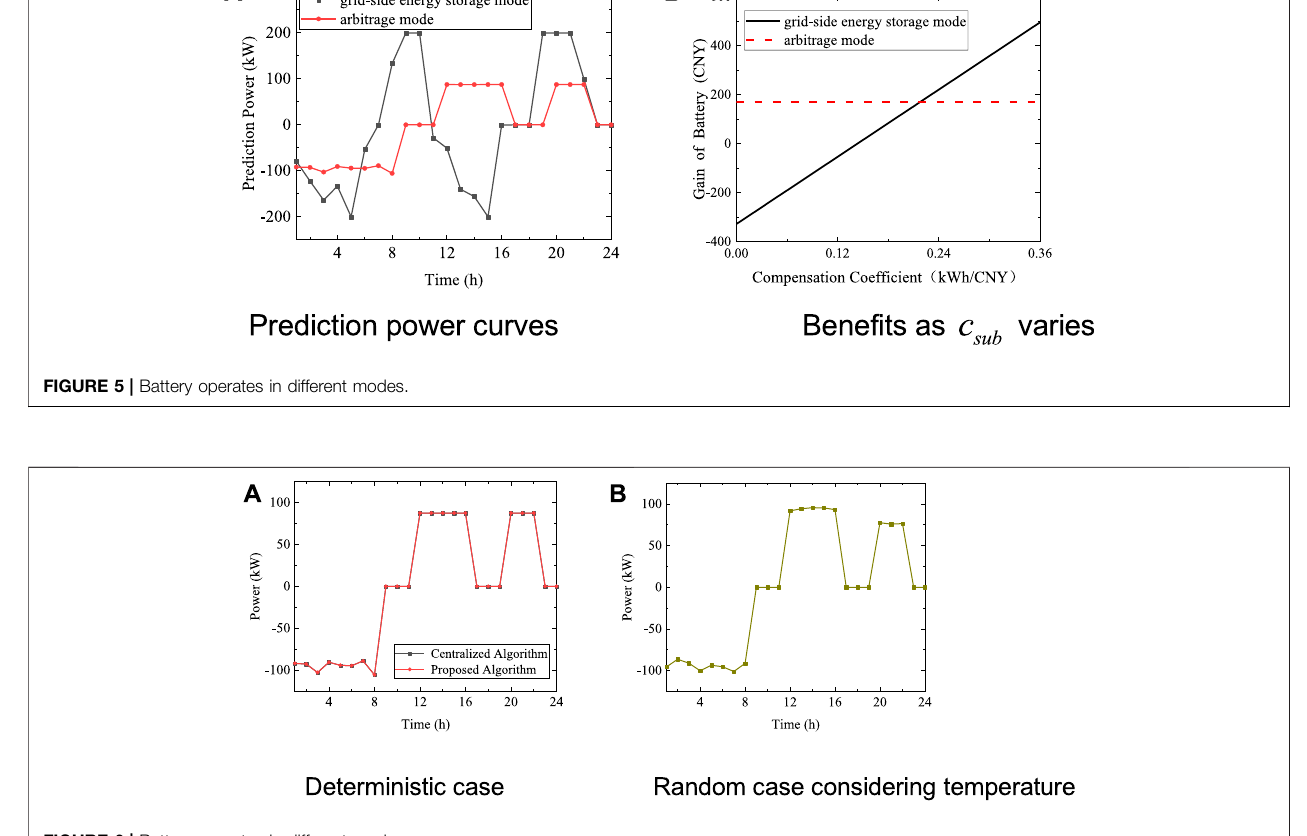
FIGURE 6 | Battery operates in different modes.